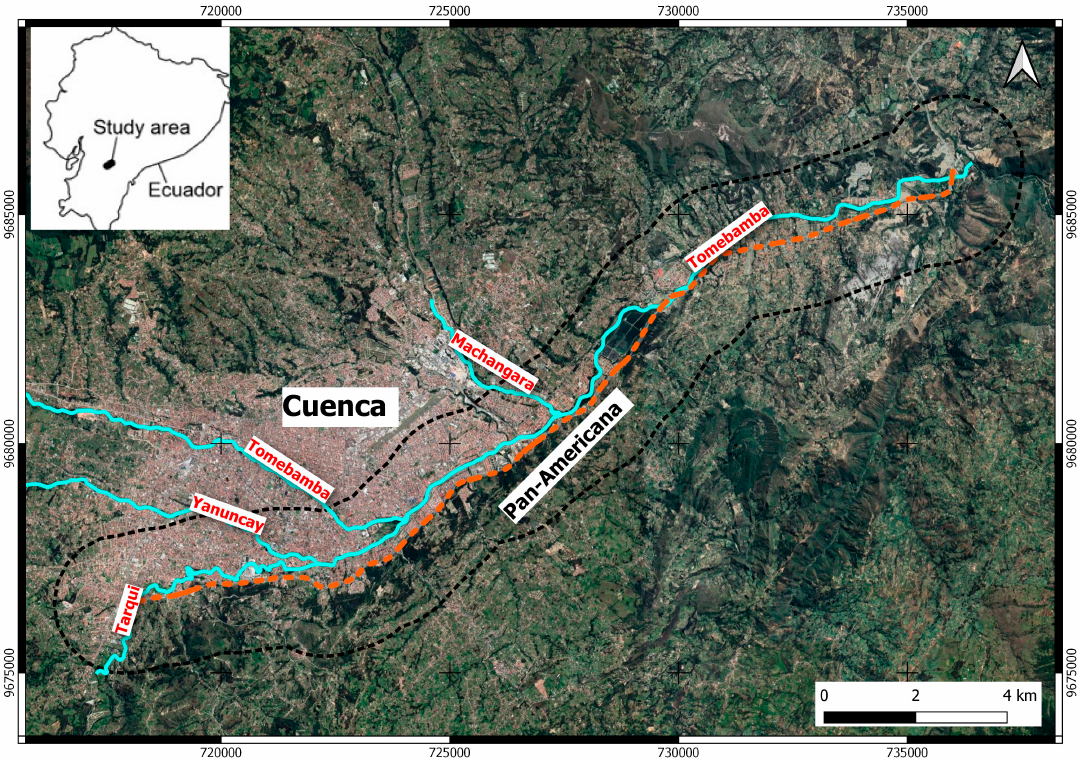
Figure 1. The Pan-American Highway between the city of Cuenca and Azogues (red dashed line) and the buffer zone surrounding the infrastructure (black polygon).